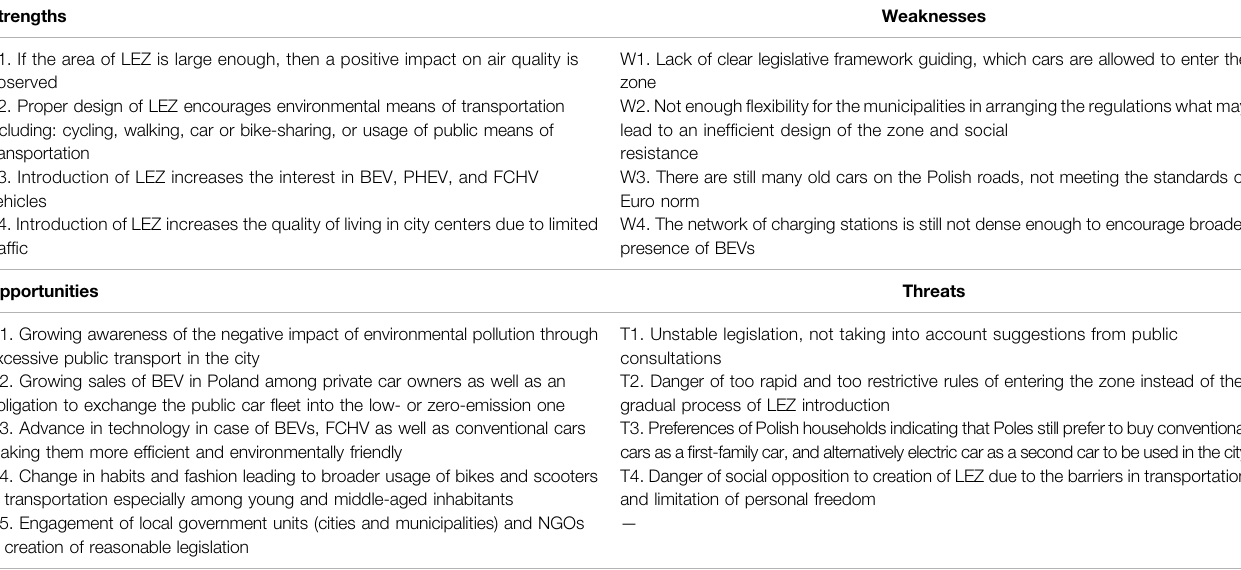
TABLE 2 | SWOT analysis of LEZ in